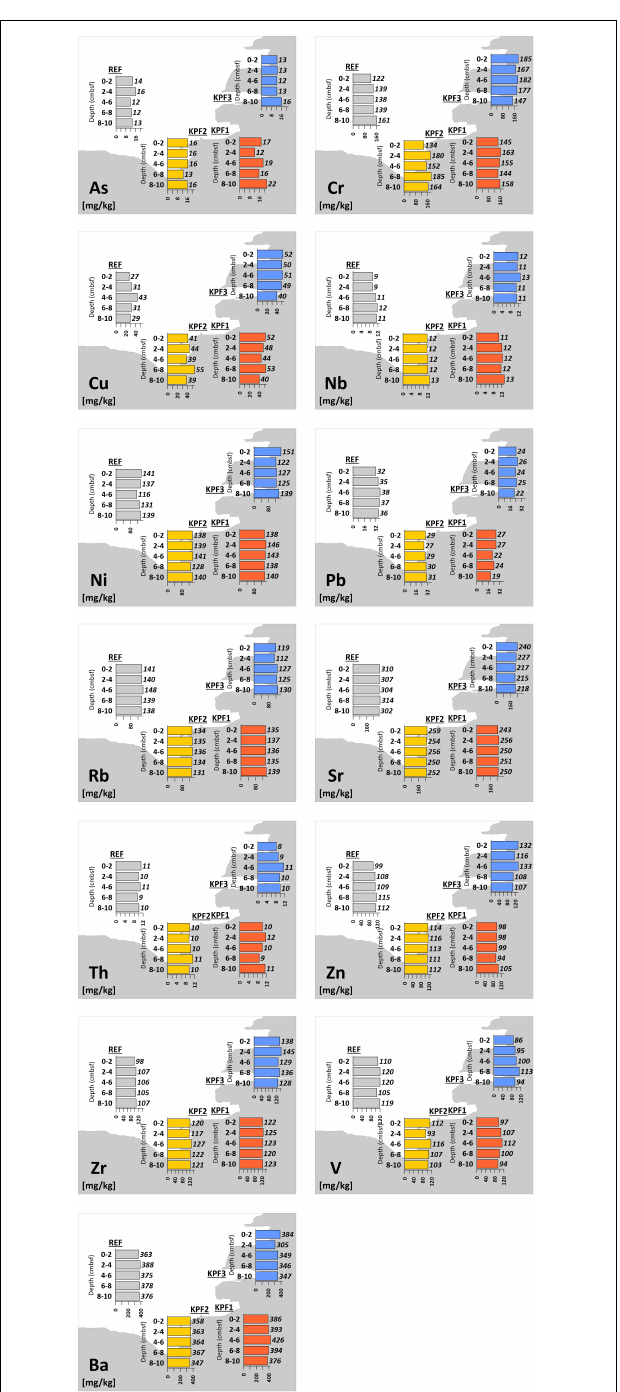
FIGURE 4 | Concentrations of trace elements (mg/kg) of sediments of Bay of Koper (cmbsf = cm below sediment floor).